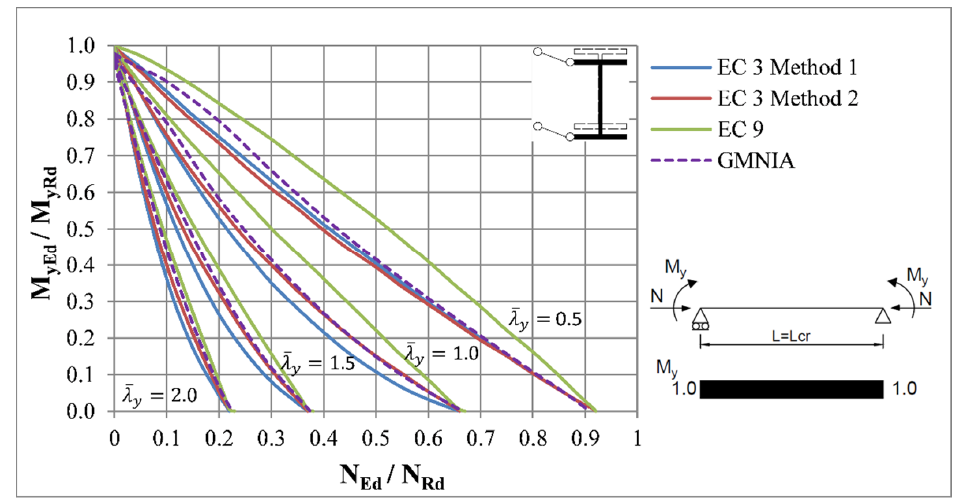
Figure 9. Interaction curves for laterally restrained beam-columns with IPE 100 cross-section.